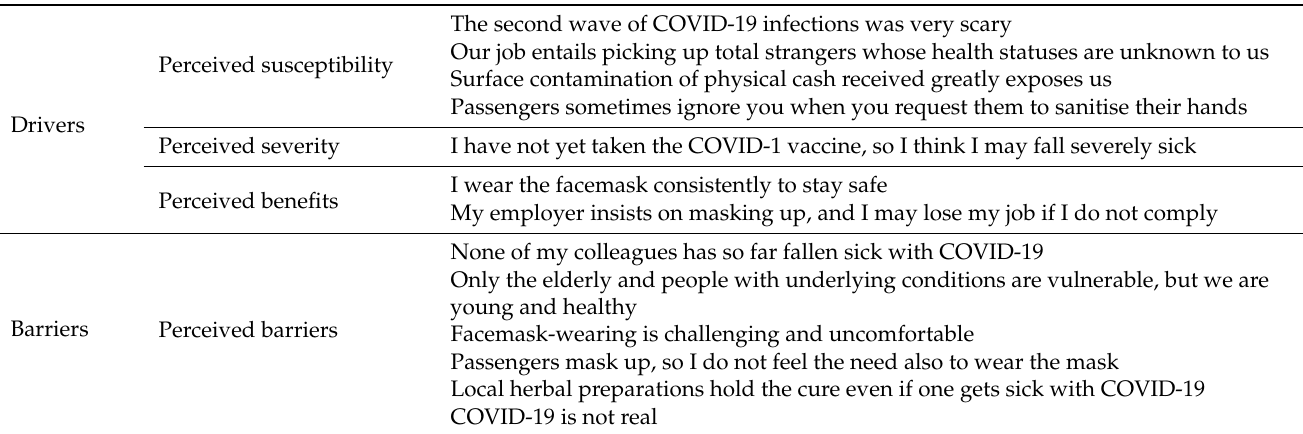
Table 7. Perceptions towards COVID-19 based on the health belief